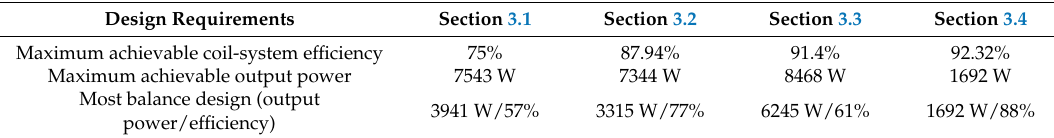
Table 1. Comparison among the four coil structure design